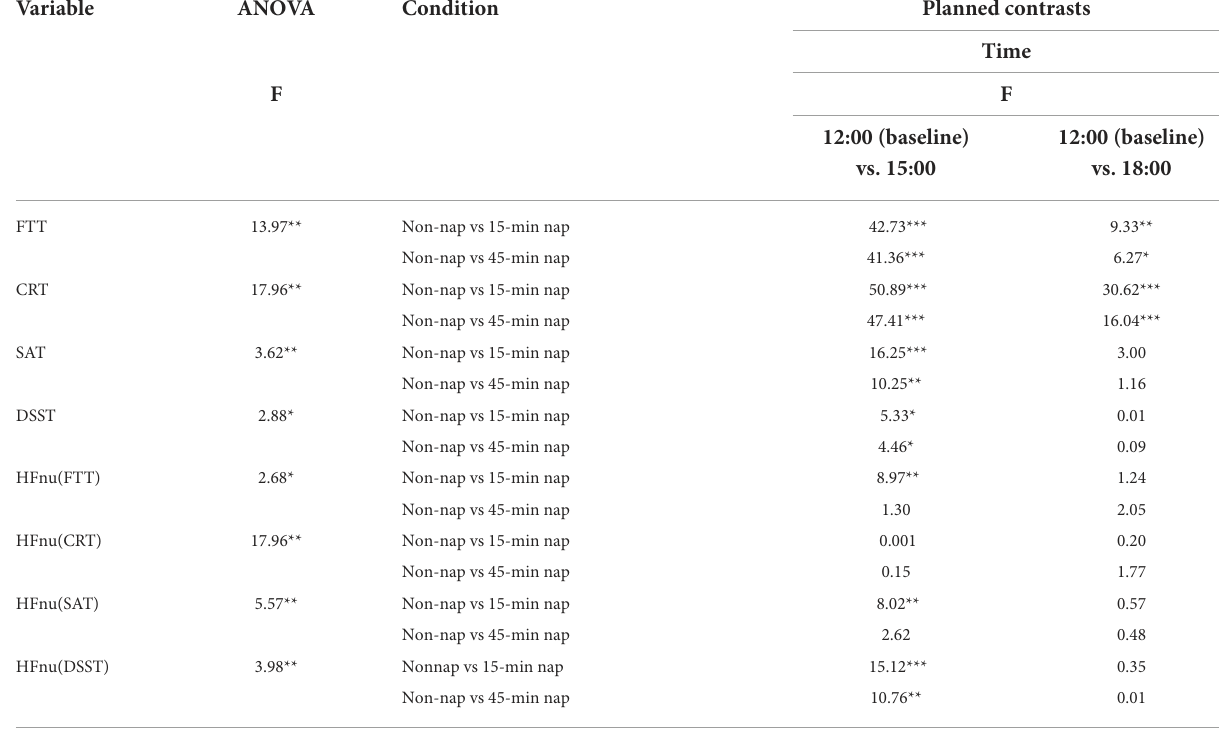
TABLE 2 Two-way ANOVA interaction effects and planned within-subjects contrasts for condition (non-nap vs. other nap condition) by time (pre-nap vs. post-nap time) for all dependent variables. Variable ANOVA Condition Planned contrasts